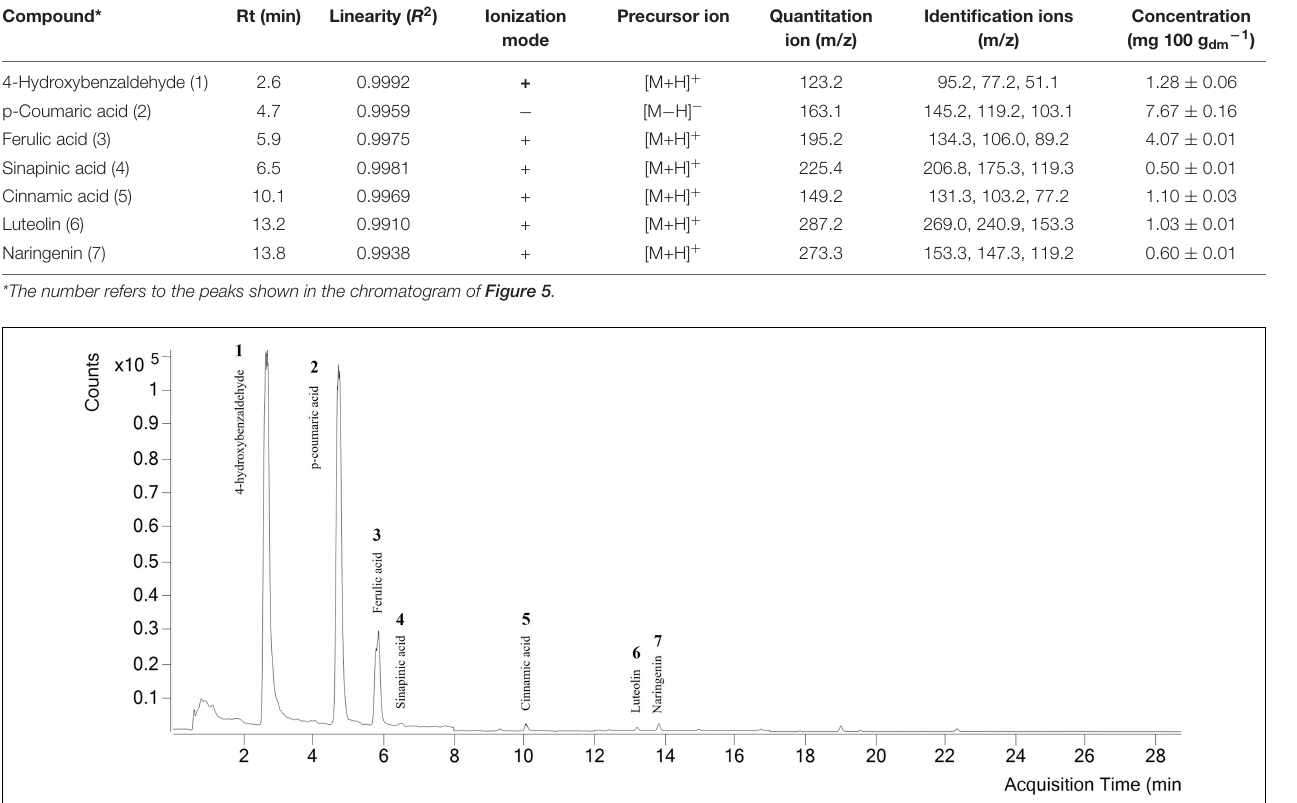
FIGURE 5 | Chromatogram obtained by UHPLC-ESI-MS/MS from the DP extract peak